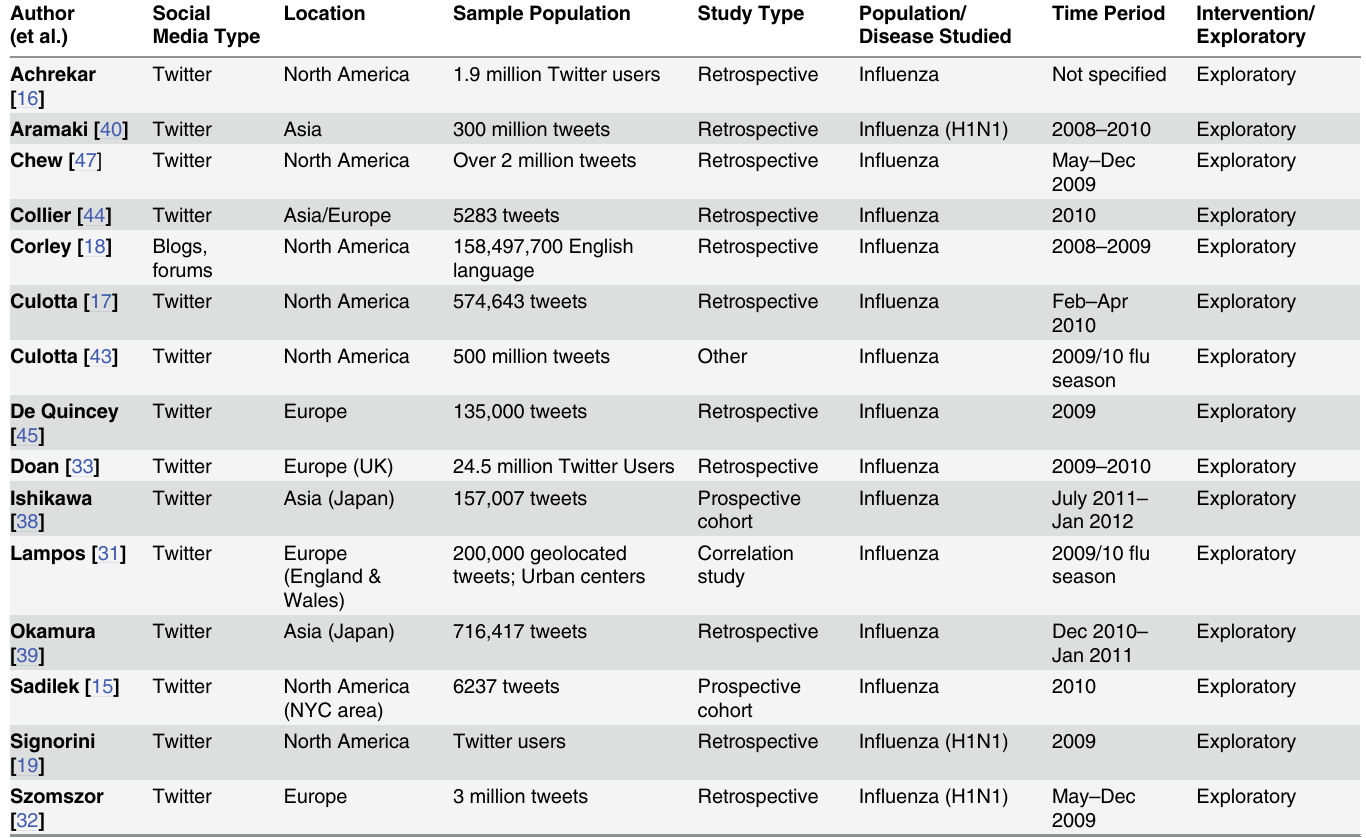
Table 3. Characteristics of 15 influenza-like illness studies addressing research question 1 a